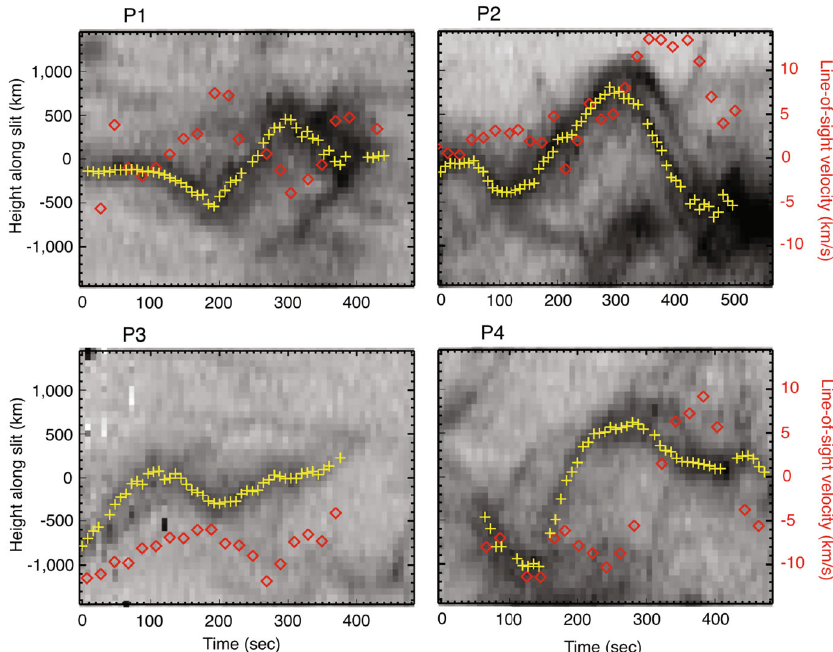
Fig. 15 Thread oscillations simultaneously detected with Hinode and IRIS. Each panel presents a space- time plot (grey scale) at a fixed prominence position from Hinode/SOT Ca ii H images. The yellow crosses denote the central position of the threads. Moreover, the red diamonds give the line-of-sight velocity, at the same position, obtained from IRIS spectra in the Mg ii k line. Image reproduced with permission